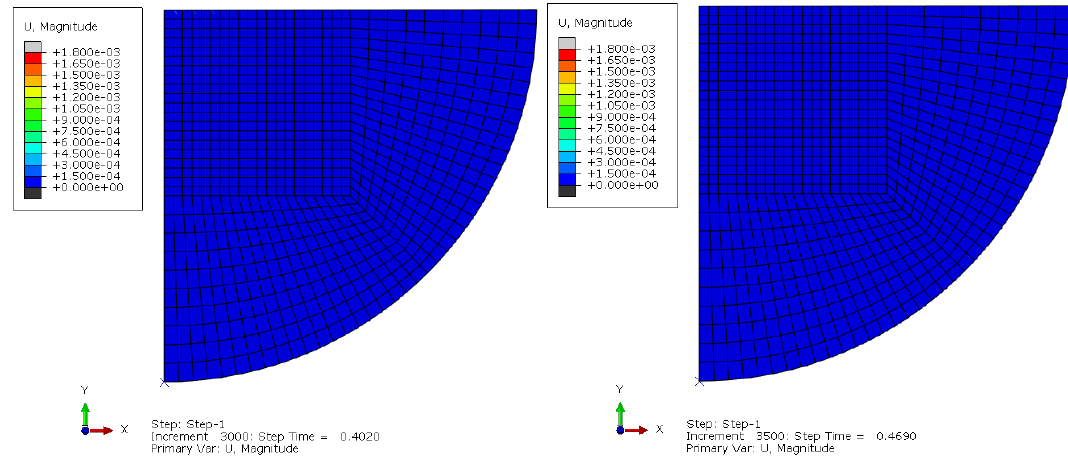
Figure 12. Displacement contours after the wave passed out of the